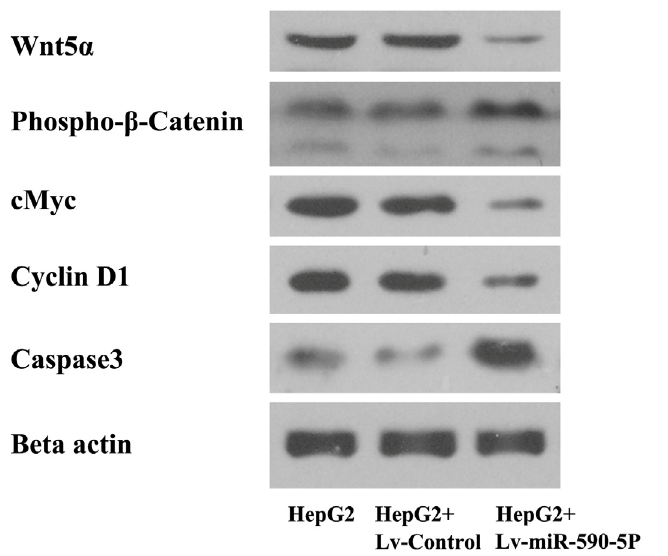
Figure 6. Effects of miR-590-5P on the Wnt pathway and downstream proteins. HepG2 cells were infected with or without Lv-Control or Lv-miR-590-5P. Ninety six hours later, expression of Wnt5a, cMyc, cyclin D1, Caspase 3 and phosphorylation levels of β -catenin were determined by western blotting, using β -actin as a loading